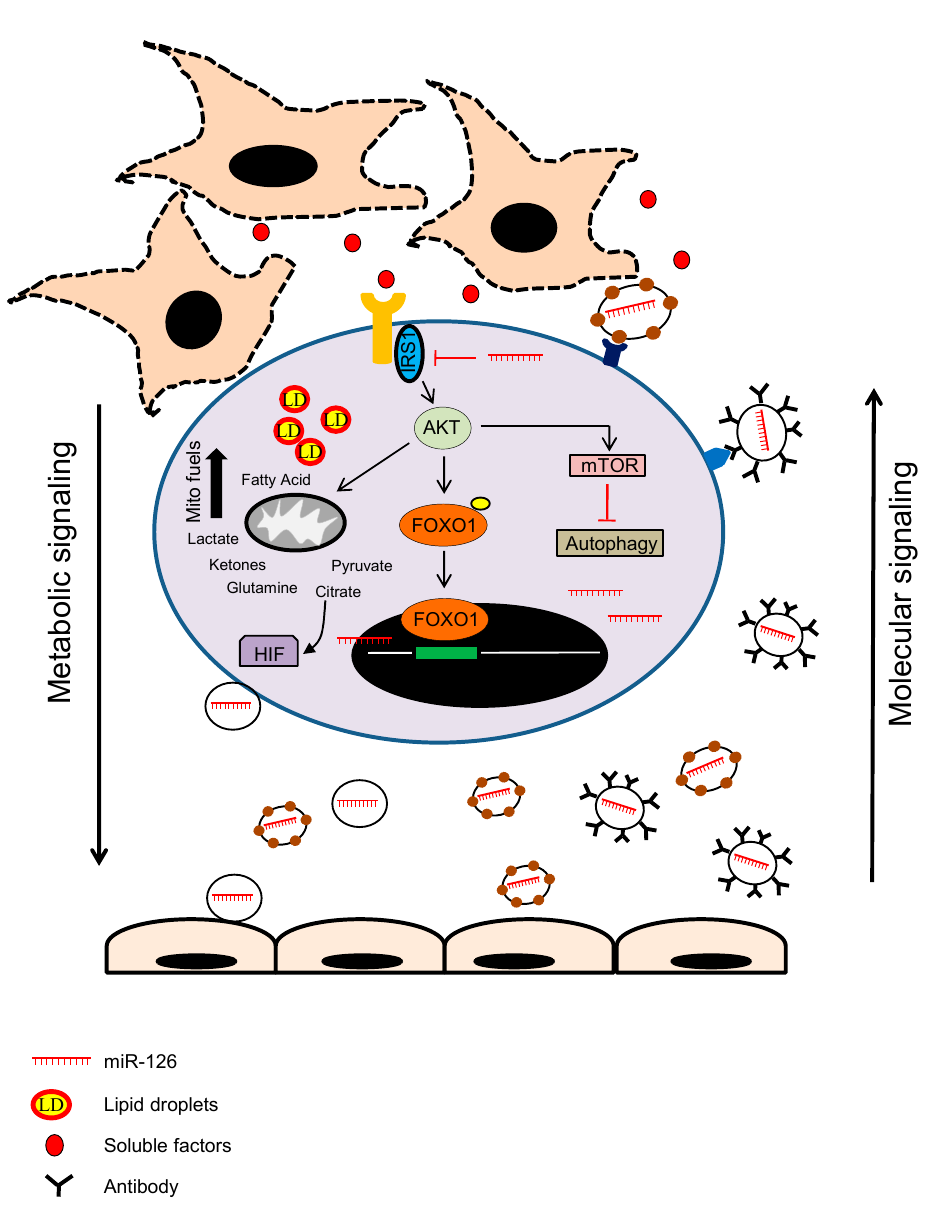
Figure 2. Cross-talk between cancer cells and cancer-associated fibroblasts (CAFs) in the regulation of miRNA expression. In the tumour microenvironment, the cross-talk between the carcinoma cells and CAFs yields soluble factors inducing downregulation of endothelial cell-specific miRNAs, such as miR-126, with resulting induction of proliferation, angiogenesis and malignancy. Restoration of miR-126 inhibits the IRS-AKT pathway, thus initiating a metabolic programme leading to high autophagic flux and HIF1 α stabilisation, plus angiogenesis inhibition incompatible with tumour progression.